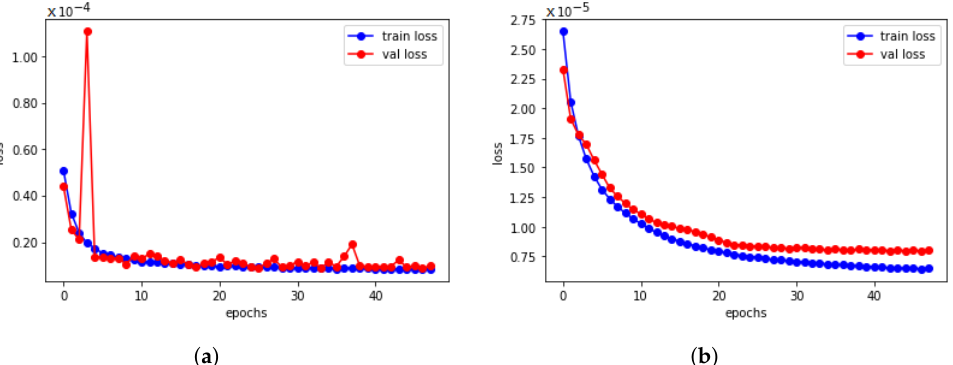
Figure 5. Train loss and validation loss of training. ( a ) Loss of FCNN; ( b ) Loss of Multi layer